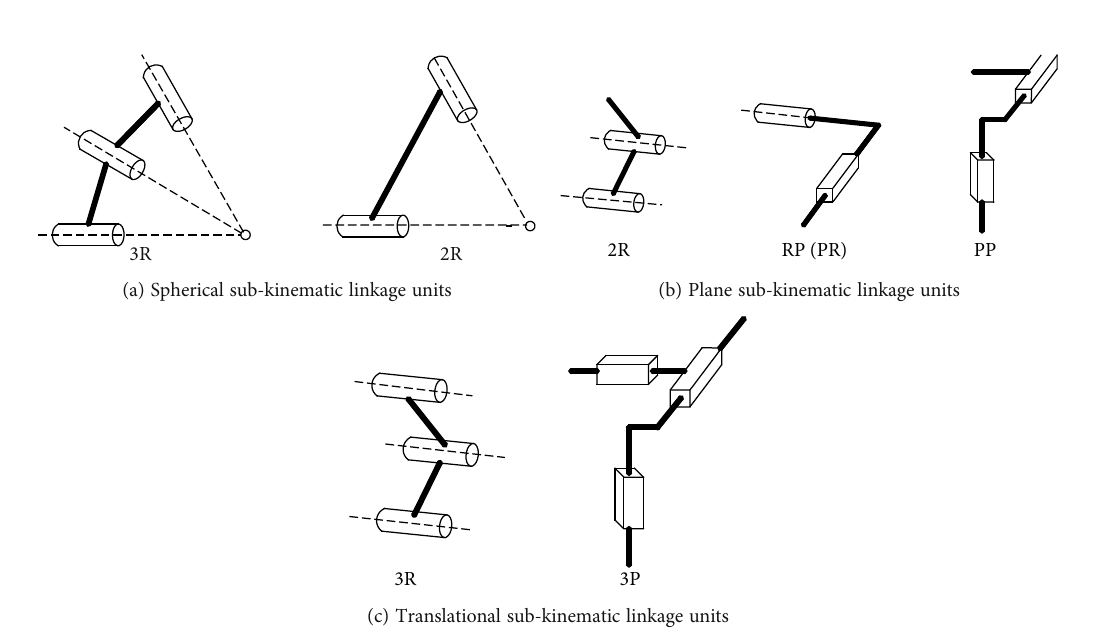
Figure 9: Subkinematic linkage units of series